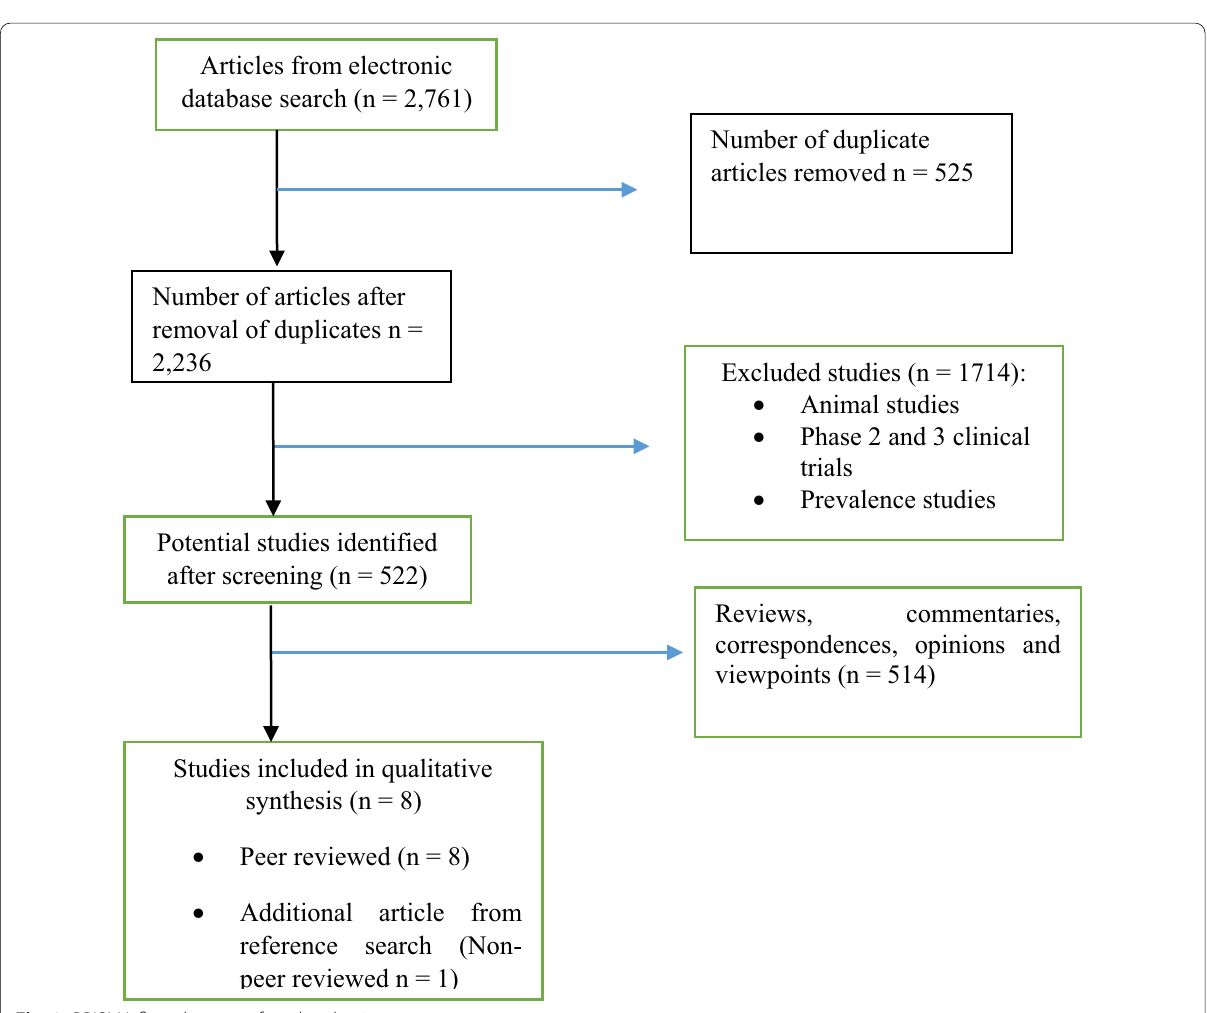
Fig. 2 PRISMA flow diagram of study